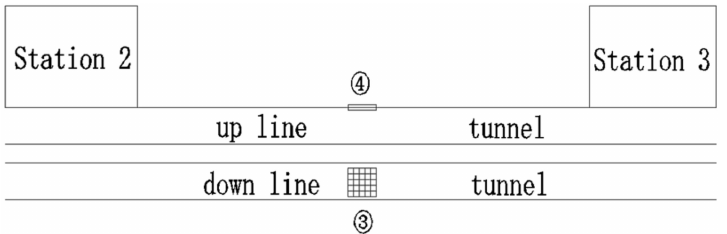
Figure 1. The location of station air shafts in Line 1.